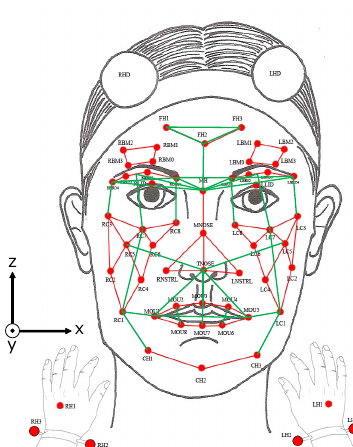
Figure 3: Motion capture marker-set of the IEMOCAP database. The vertical axis represents the x direction and the horizontal axis shows the z direction, respectively ([28] is